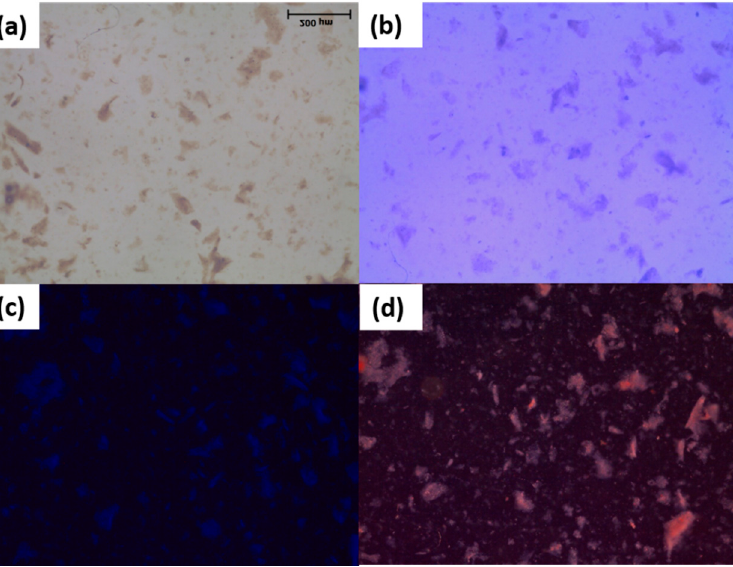
Figure 2. Polarized microscope image for the m THPP-loaded nanocomposite. ( a ) No filter; ( b ) 530 nm filter; ( c ) cold blue light; ( d ) daylight cold blue